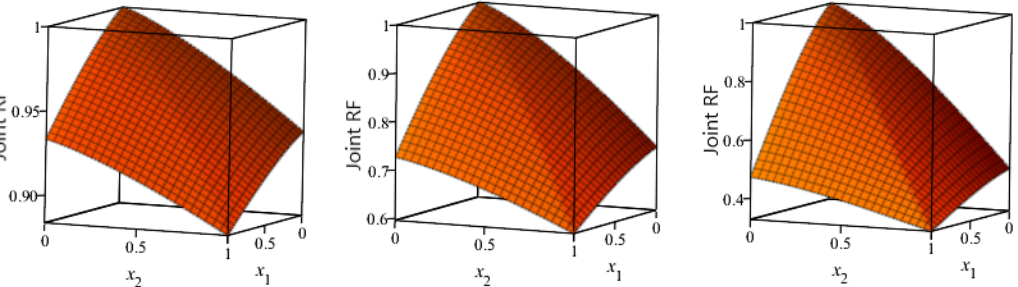
Figure 2. The surface plots of the joint RF for γ 1 = γ 2 = γ 3 = 0.3 and a = 0.1, 0.3 and 0.5, respectively.